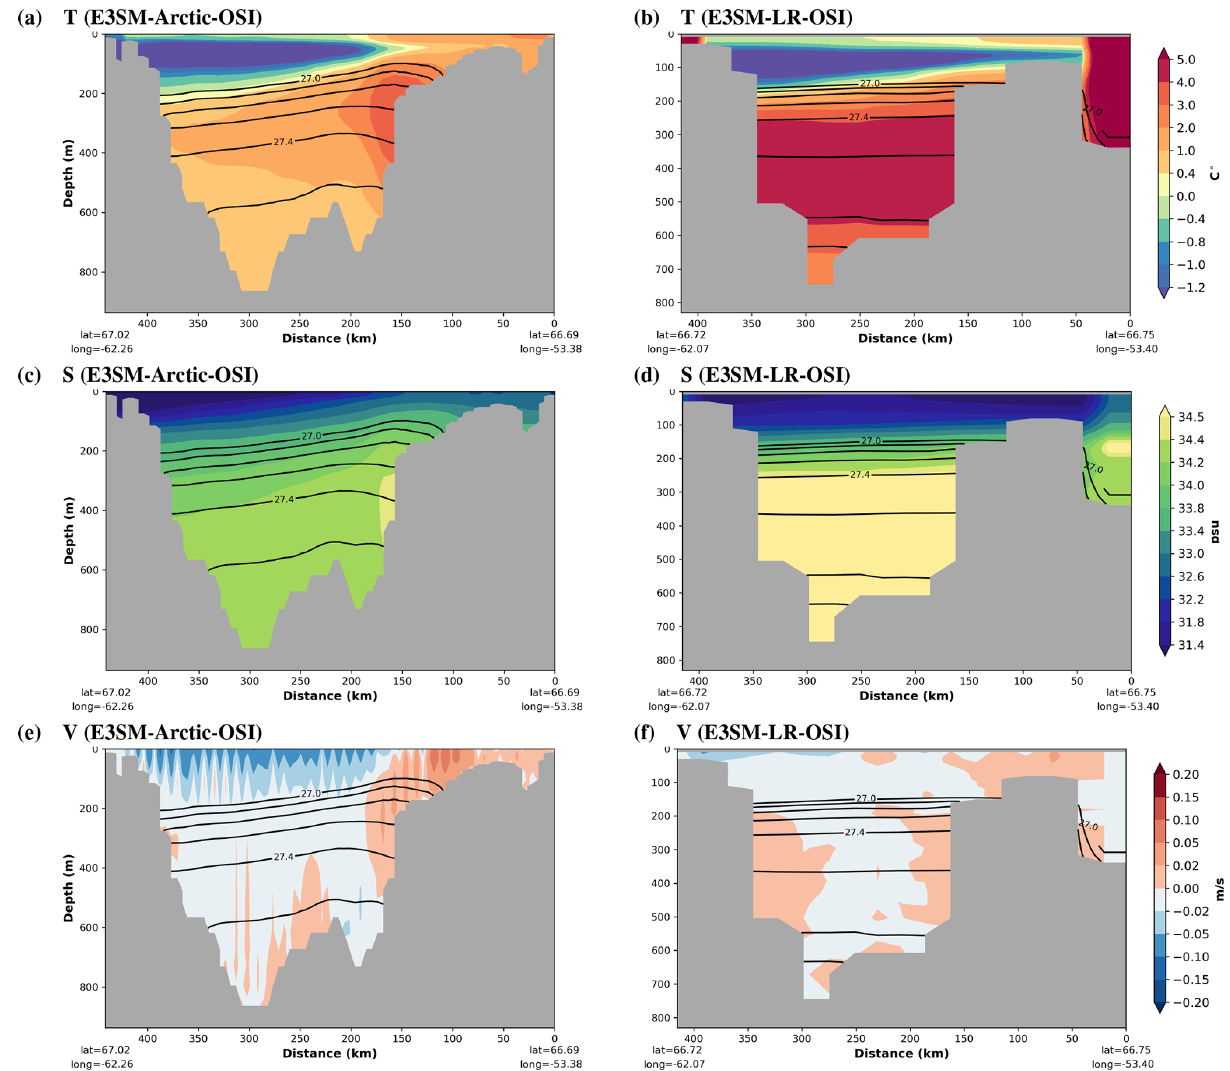
Figure 12. Similar to Fig. 10 but for the Davis